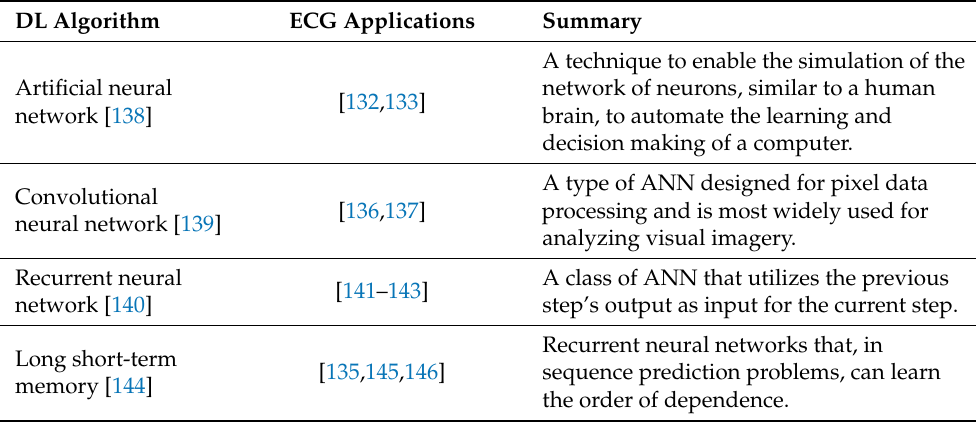
Table 4. Summary of commonly used deep learning (DL)